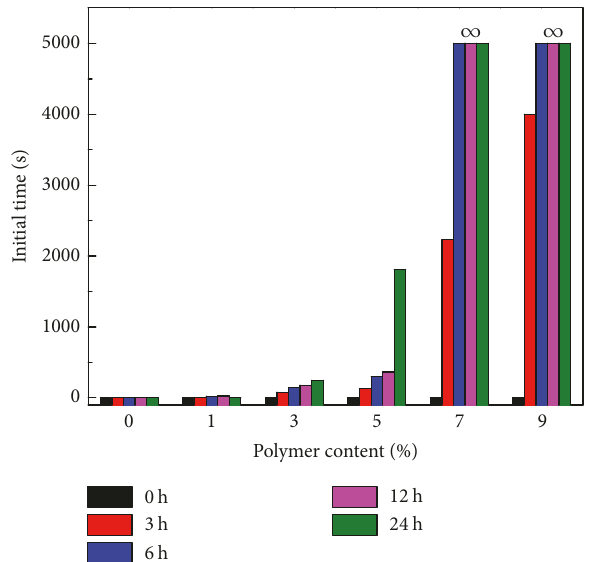
Figure 7: Initial time of running water from bottom outlet.